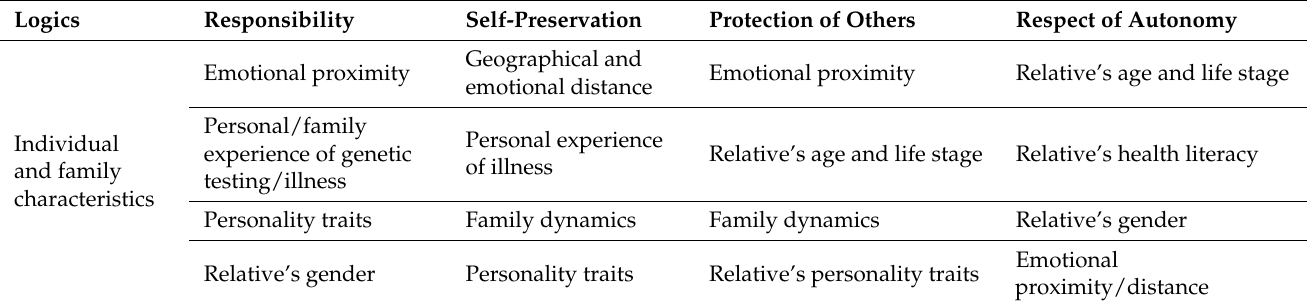
Table 4. Interconnection between probands’ logic and individual and family